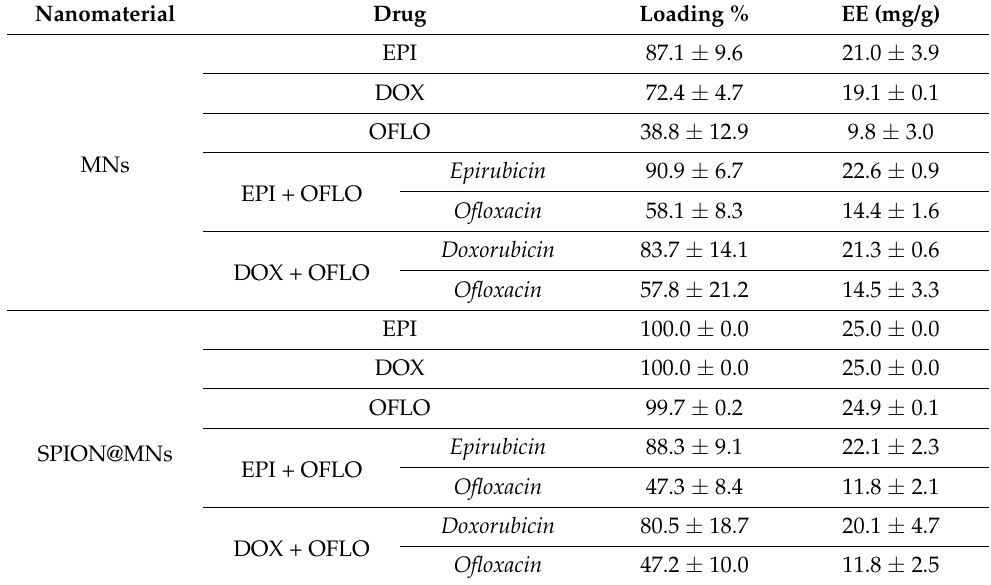
Table 1. MNs and SPION@MNs’ loading assay loading percentages and encapsulation efficiency (EE) for single and dual-combinatory formulations of EPI, DOX, and